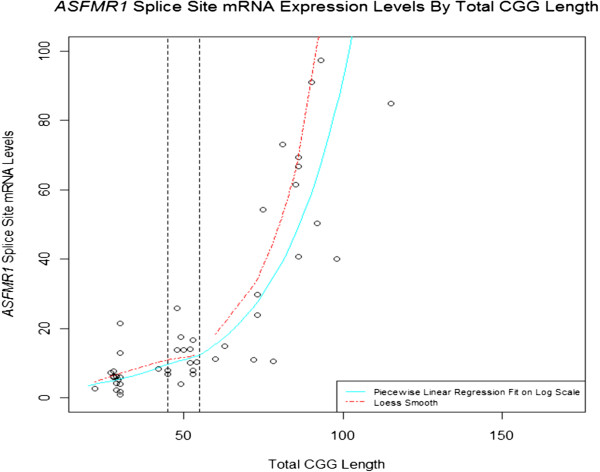
Expression of the minor splice isoform in the ASFMR1 transcript (131 bp), located near the ASFMR1 promoter. Expression of this isoform increases in premutation carriers (P < 0.001), and shows a similar trend in subjects with intermediate alleles (P = 0.0528) compared with normal alleles. The solid blue line on the plot shows a piecewise linear regression fit (fitted on the log scale then exponentiated for plotting), with separate slopes in the normal, intermediate, and premutation alleles.